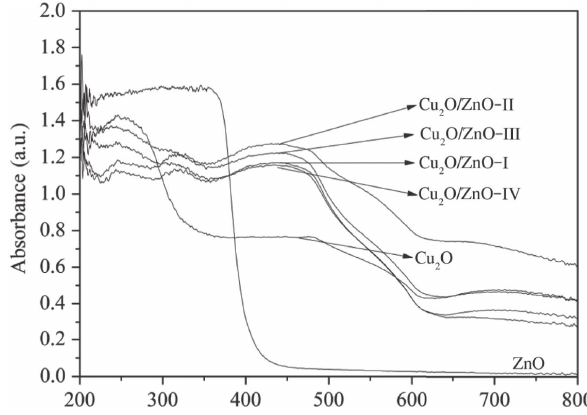
Figure 6: UV-vis spectra of Cu 2 O/ZnO prepared with different Cu 2 O